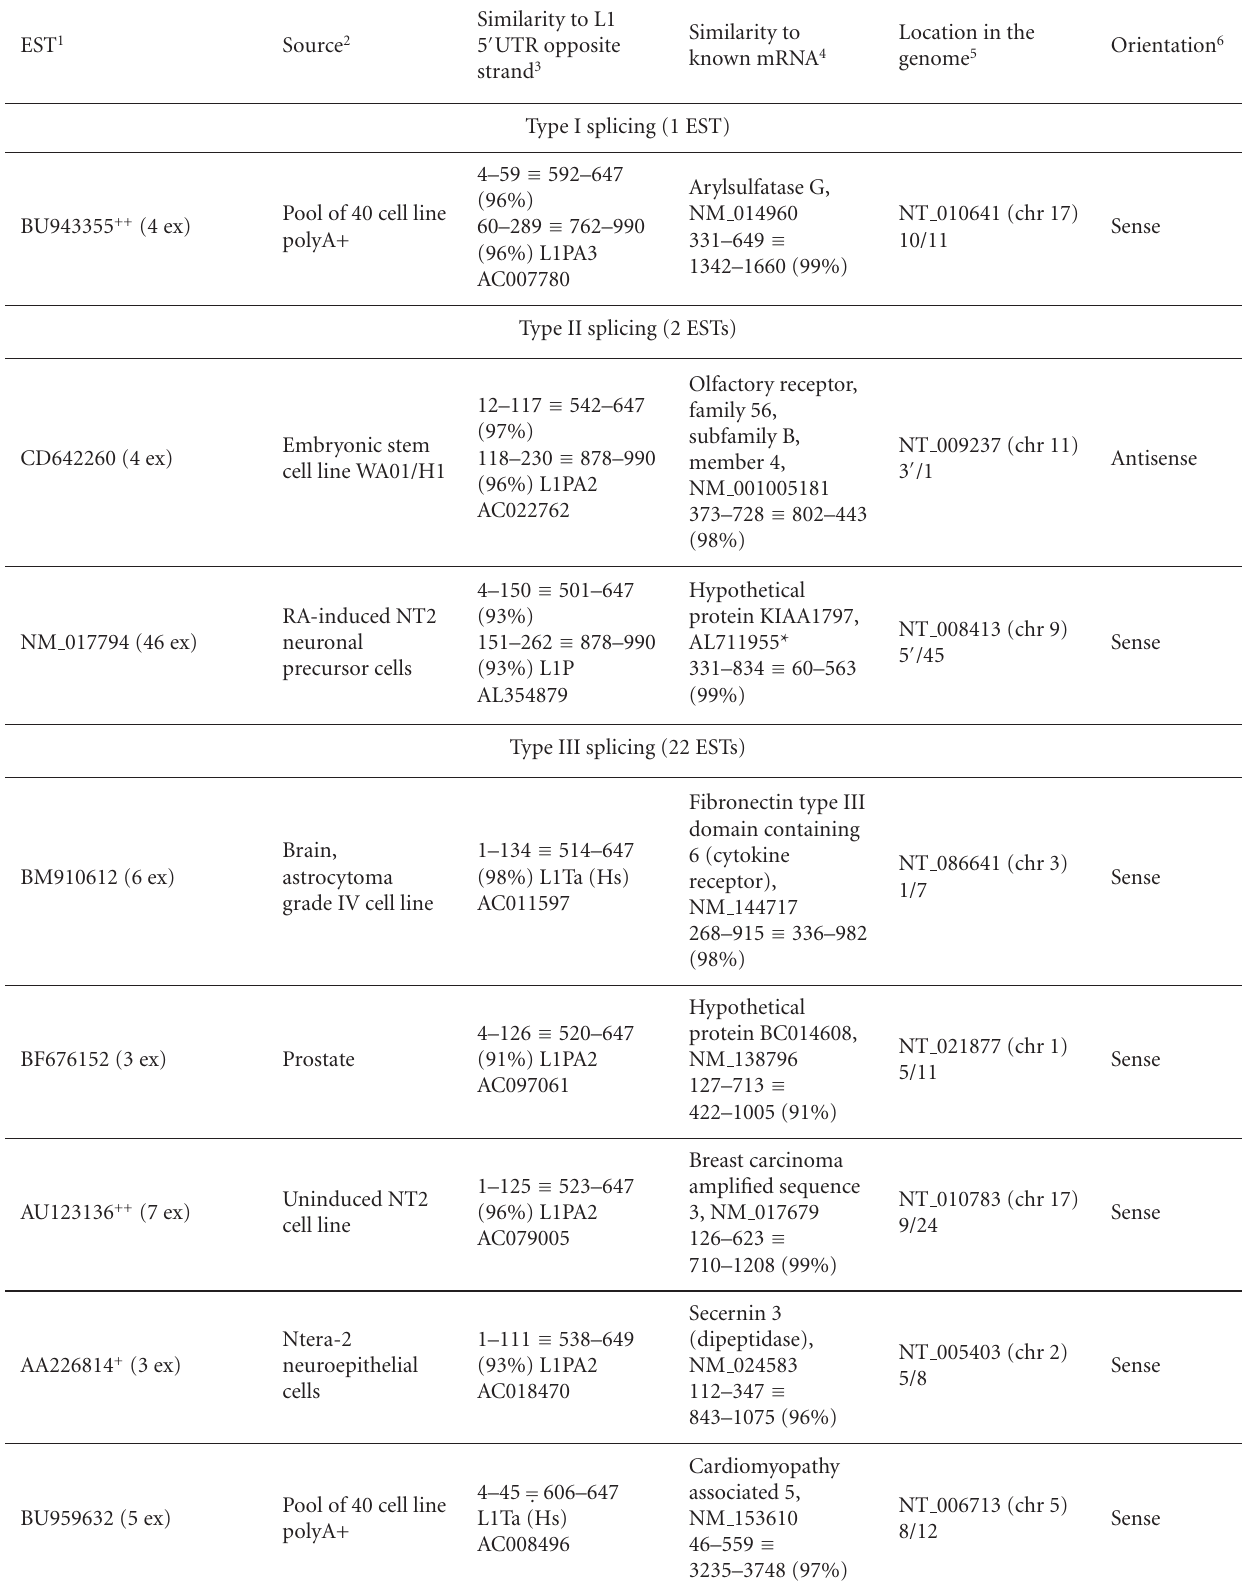
Table 2: Widespread L1 ASP-driven transcription of human genes revealed from